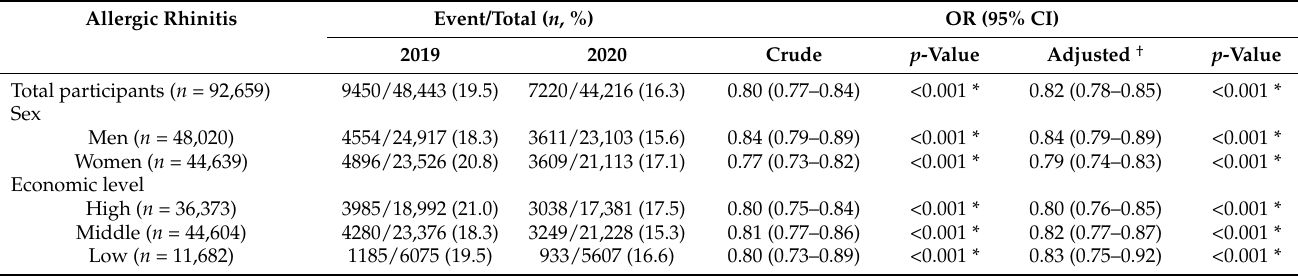
Table 3. Odd ratios in allergic rhinitis of 2020 compared to those in 2019 in total participants and subgroup. Allergic